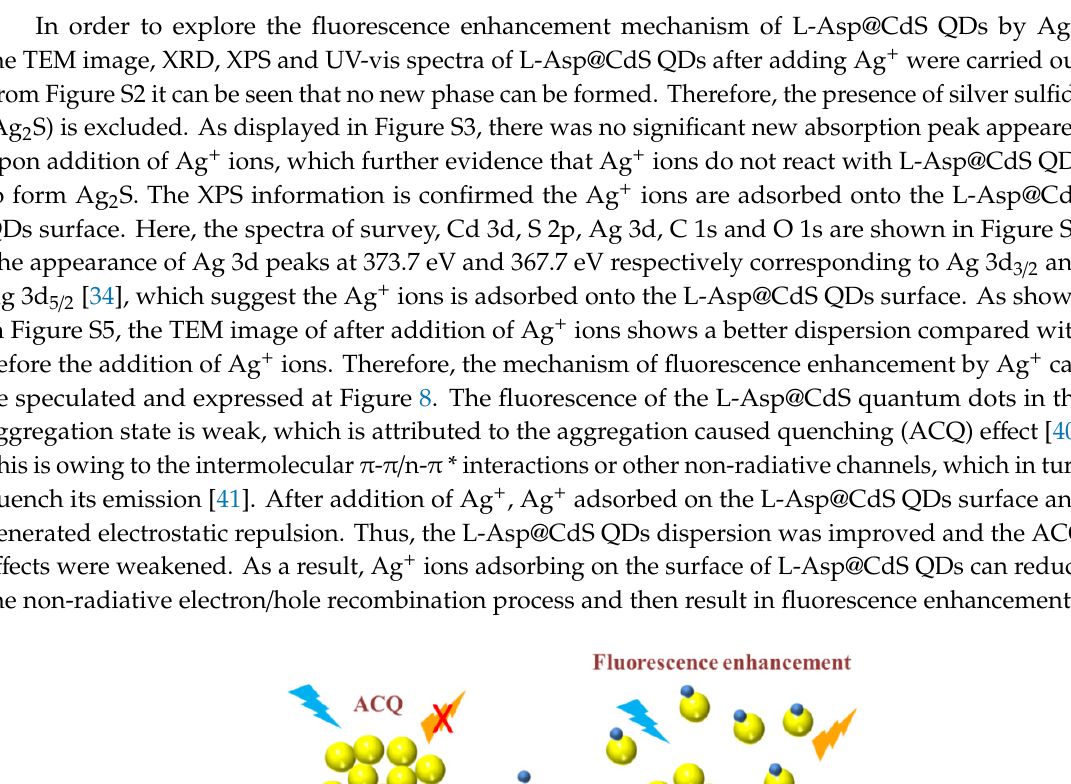
Table 2. Analytical results of drinking water samples.